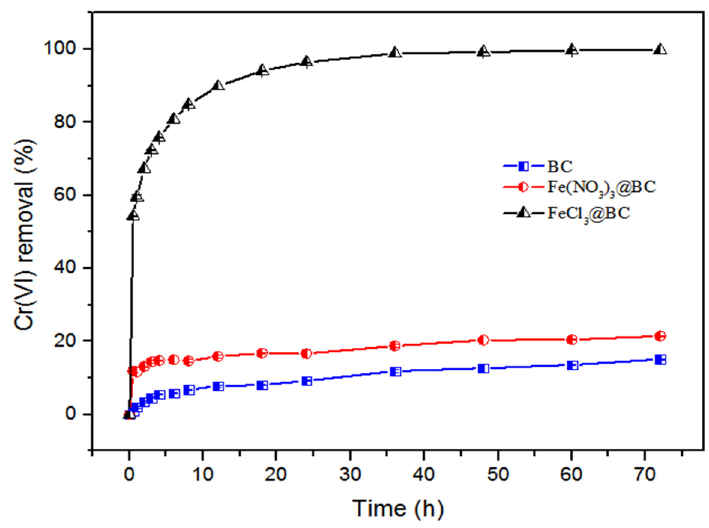
Figure 1. The quantity of Cr(VI) eliminated by BC, FeCl 3 @BC, and Fe(NO 3 ) 3 @BC.